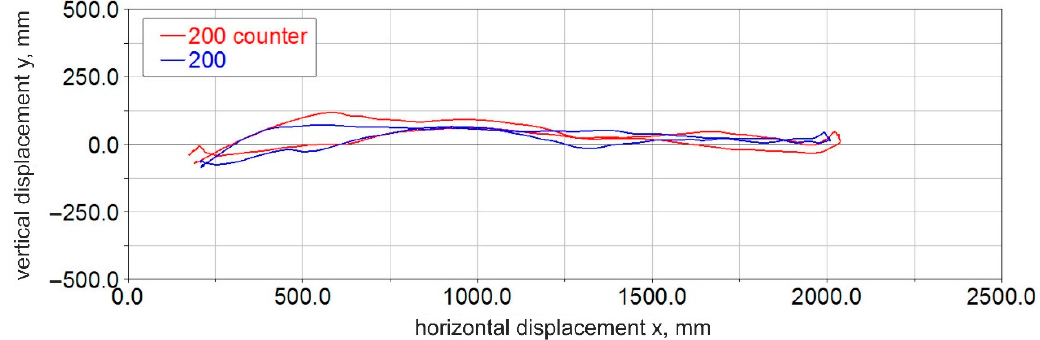
Figure 11. Manipulator’s effector trajectories for a velocity of 200 mm/s.